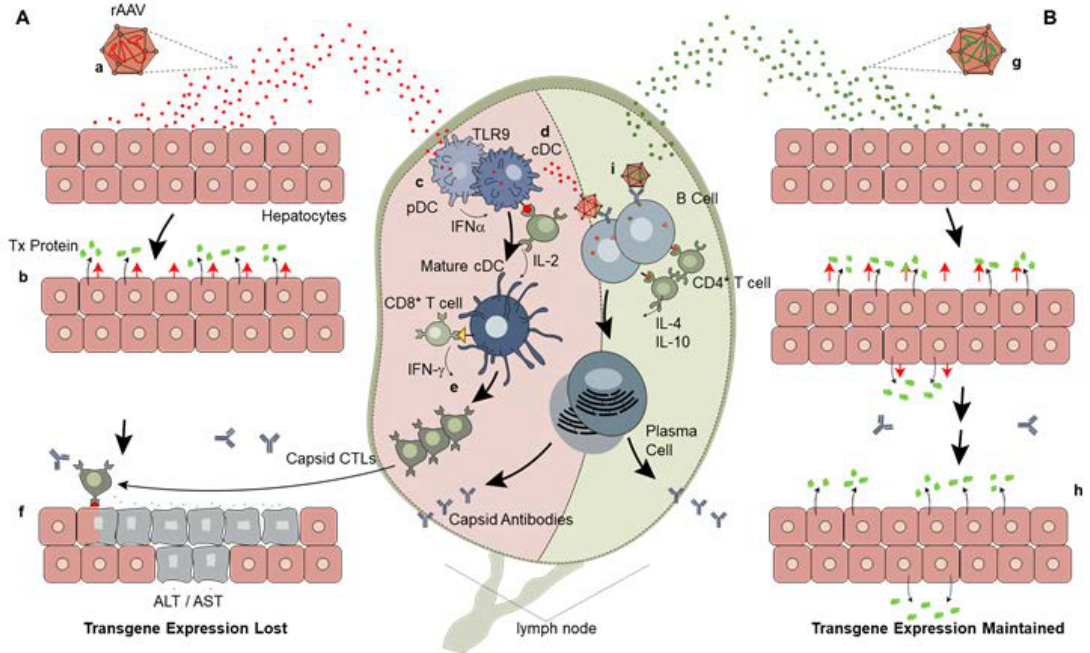
Figure 2. Mechanisms of potential immune responses to AAV vectors [30]. ( A ) Hepatocytes transduced with AAV vectors (a) express the therapeutic protein but also present capsid-derived peptides (yellow triangles) via their MHC class 1 molecules (b). A fraction of the vector dose enters proximal lymph nodes and is taken up by pDCs (c), where vector DNA is processed in the lysosome and promotes the production of proinflammatory cytokines, and by cDCs (d), where vector capsid-derived peptides (red circles) are presented by MHC class 2 molecules, recruiting capsid-specific CD4+ T-cell help. These events lead to licensing and maturation of cDCs and activation of capsid-specific CD8+ CTLs (e) that proliferate, migrate to the liver, and eliminate transduced hepatocytes (f). ( B ) An ideally designed AAV vector with low immunogenicity (g) would similarly transduce hepatocytes but would not activate innate immunity. CTLs would not be formed, transduced hepatocytes would not be eliminated, and cell-surface capsid peptide presentation would wane (h). In both scenarios, AAV vectors activate the humoral arm of the immune response (i), leading to capsid antibodies. Adapted from wright [30]. AAV, adeno-associated virus; ALT, alanine aminotransferase; AST, aspartate aminotransferase; cDC, conventional dendritic cell; CTL, cytotoxic T lymphocyte; IFN, interferon; IL, interleukin; MHC, major histocompatibility complex; PAMP, pathogen-associated molecular pattern; pDC, plasmatoid dendritic cell; TLR9, Toll-like receptor 9; rAAV, recombinant adeno-associated virus; tx,